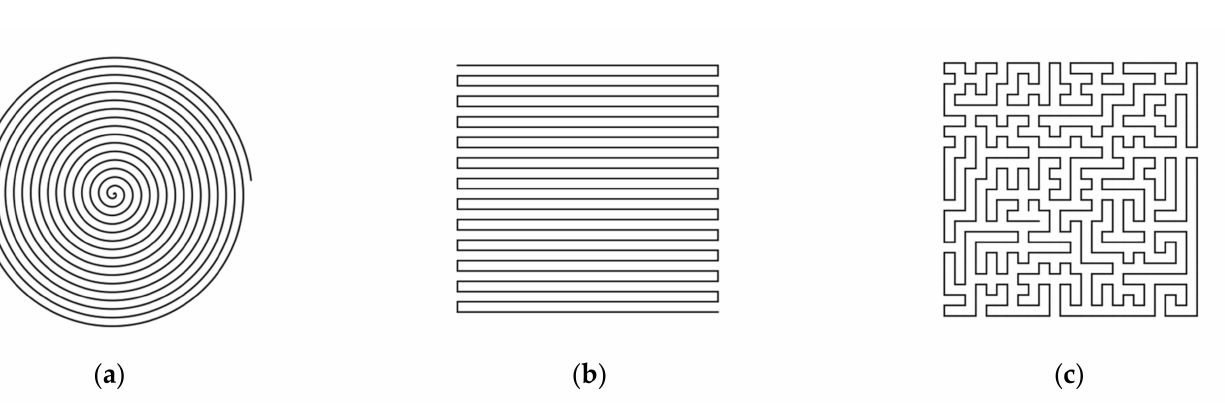
Figure 3. Tool path patterns for SATP optic fabrication. ( a ) Archimedes path; ( b ) Zig-zag path; ( c ) Pseudo-random